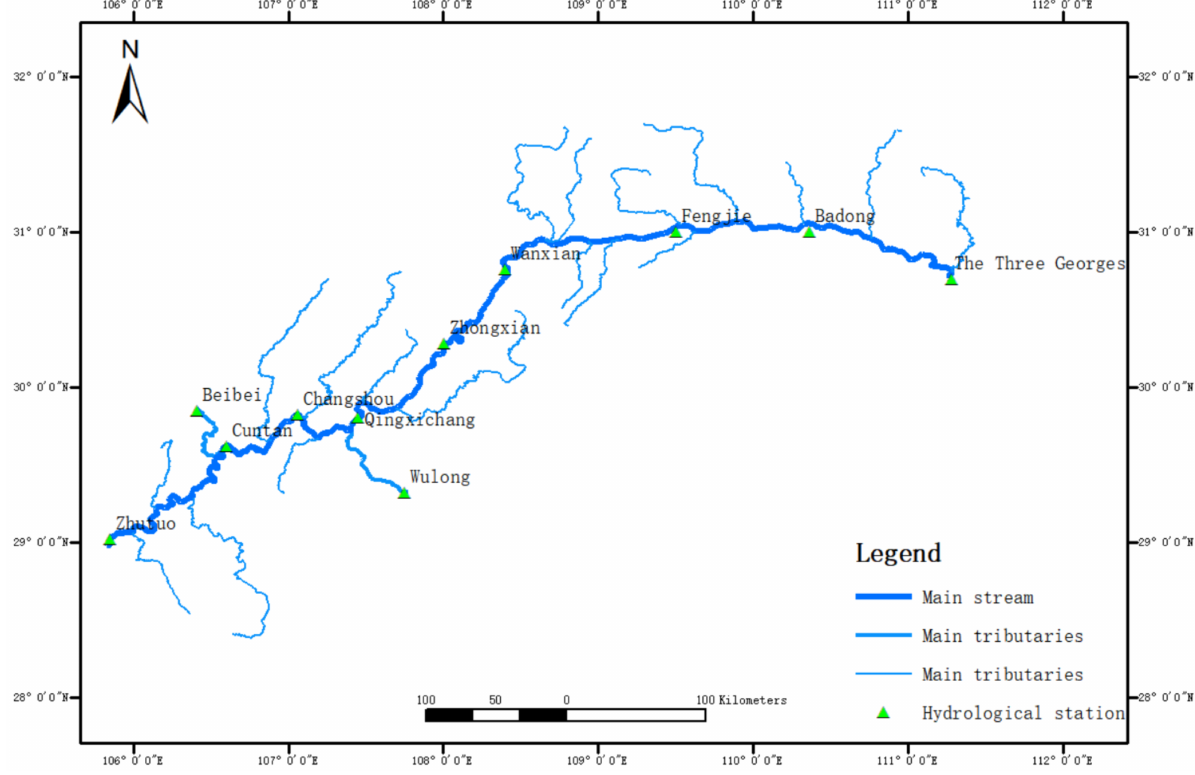
Figure 4. Schematic diagram of the study